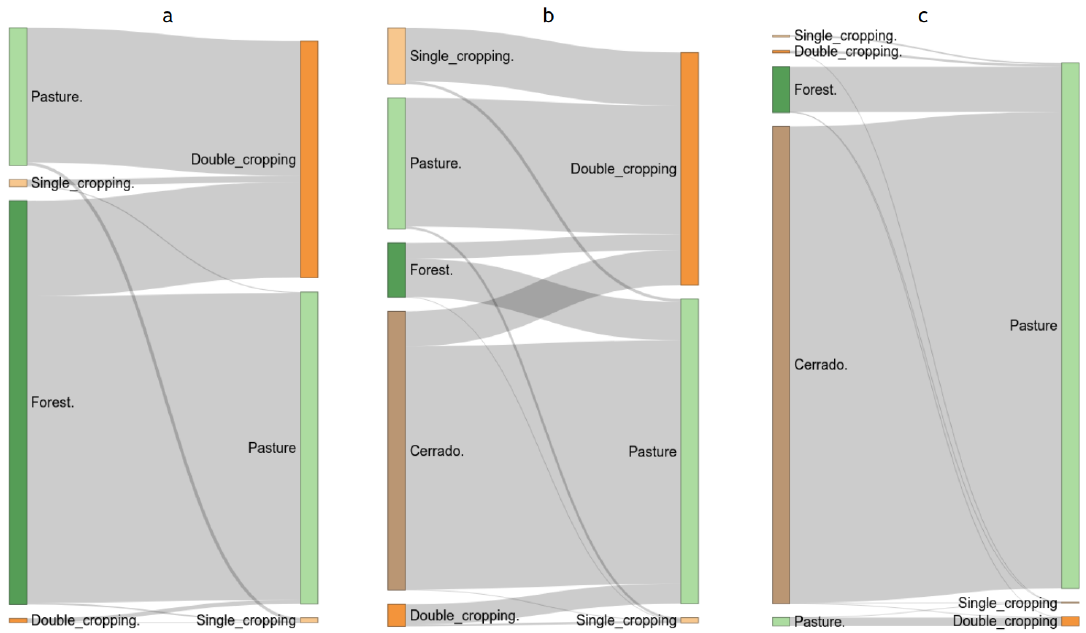
Figure 4. Land use and land cover conversions in the Mato Grosso State. ( a ) Amazon, ( b ) Cerrado, and ( c ) Pantanal biomes, from 2001 to